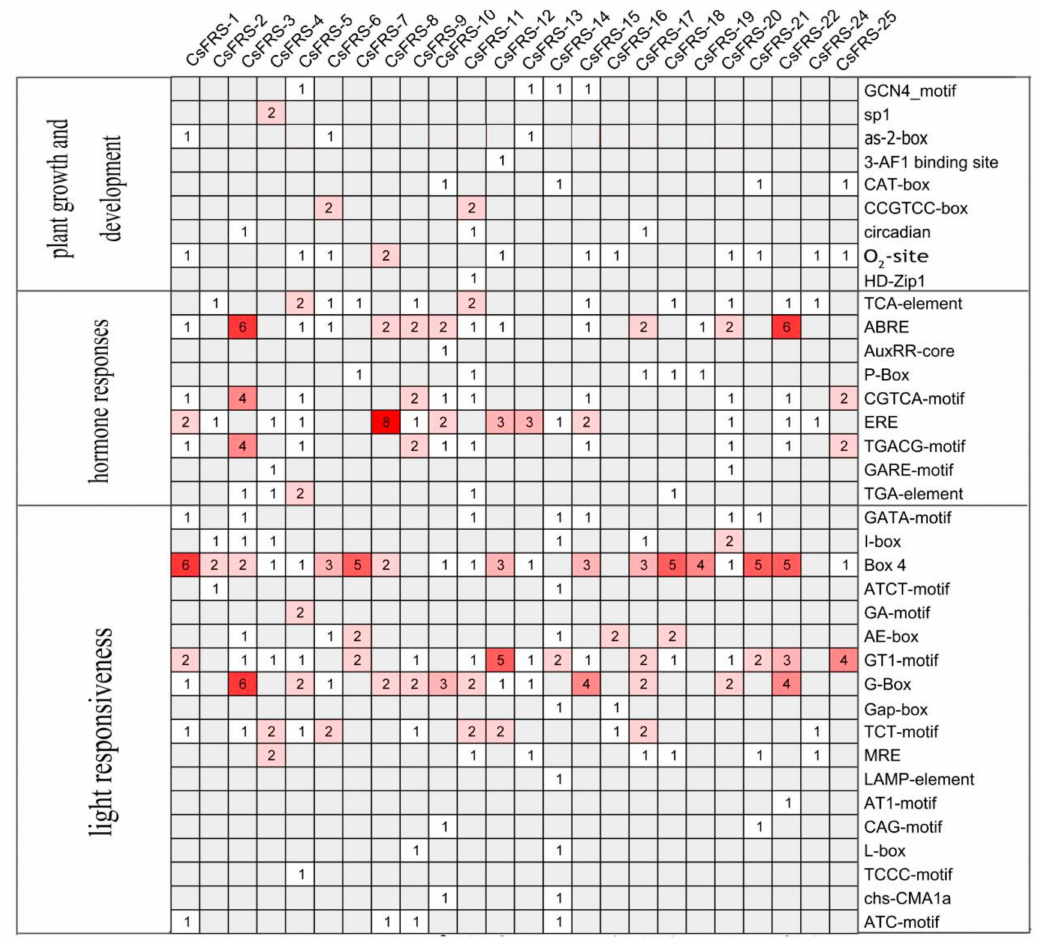
Figure 3. Cis -acting elements in promoters of CsFHY3/FAR1s